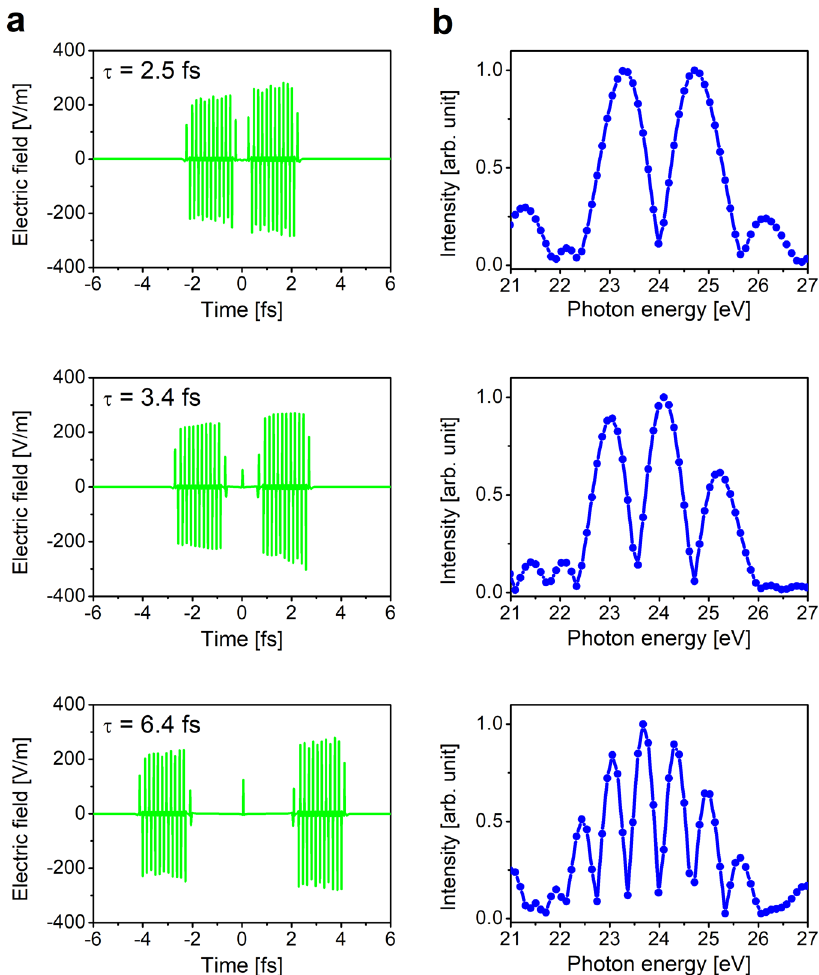
Fig. 1 Radiation from a relativistic electron traveling through a tandem undulator. a Temporal pro fi les of a light-wave packet for three different conditions of the phase shifter installed between the two undulators. These pro fi les were calculated with the synchrotron radiation calculation code SPECTRA 5 , using the nominal machine parameters of the UVSOR storage ring. The time delay τ formed by the phase shifter is noted in each panel. b Spectra of the radiation from the tandem undulator, obtained by applying the Fourier transformation to the temporal pro fi les shown in ( a